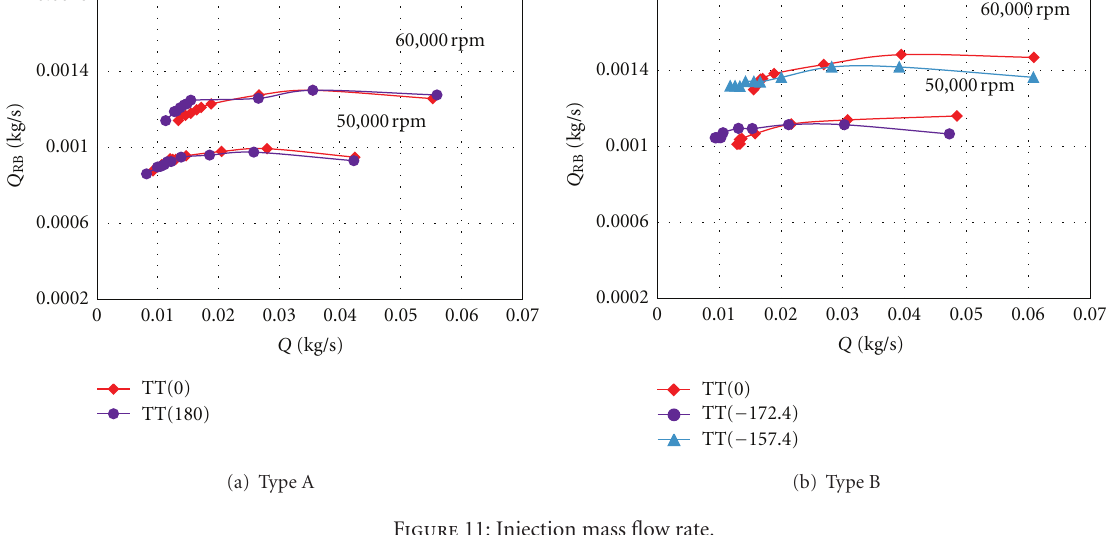
Figure 11: Injection mass flow rate.